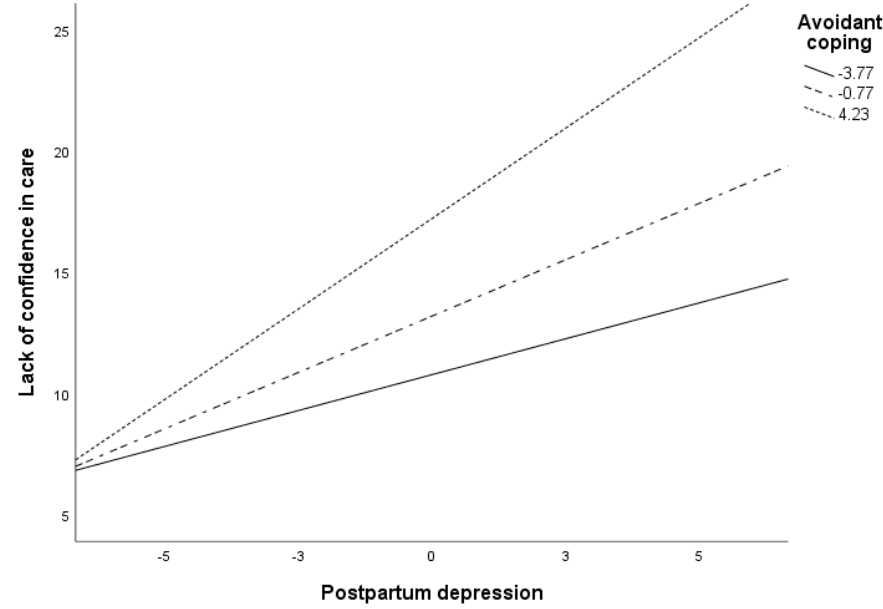
Figure 3. Conditional effects of PPD on lack of security in baby care at values of avoidance.